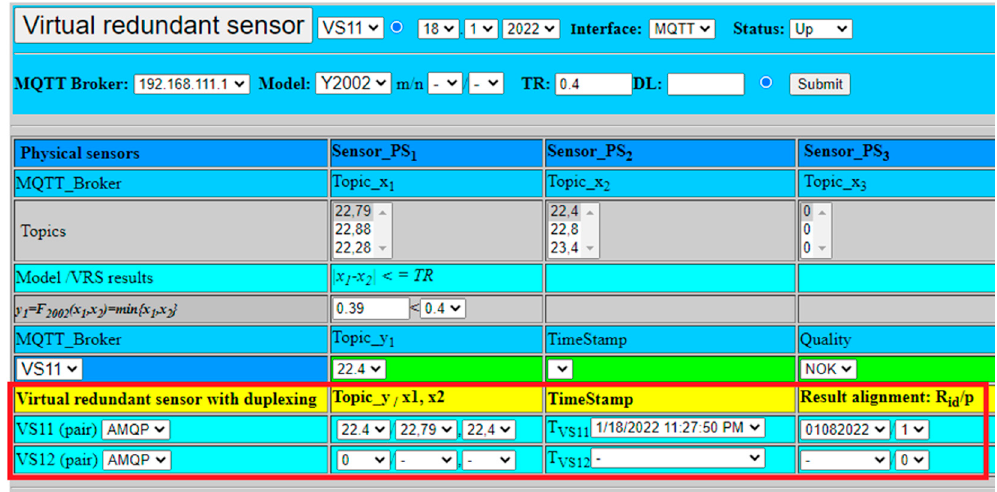
Figure 18. Virtual redundant sensor VS11 with duplexing and example of VS12 failure.